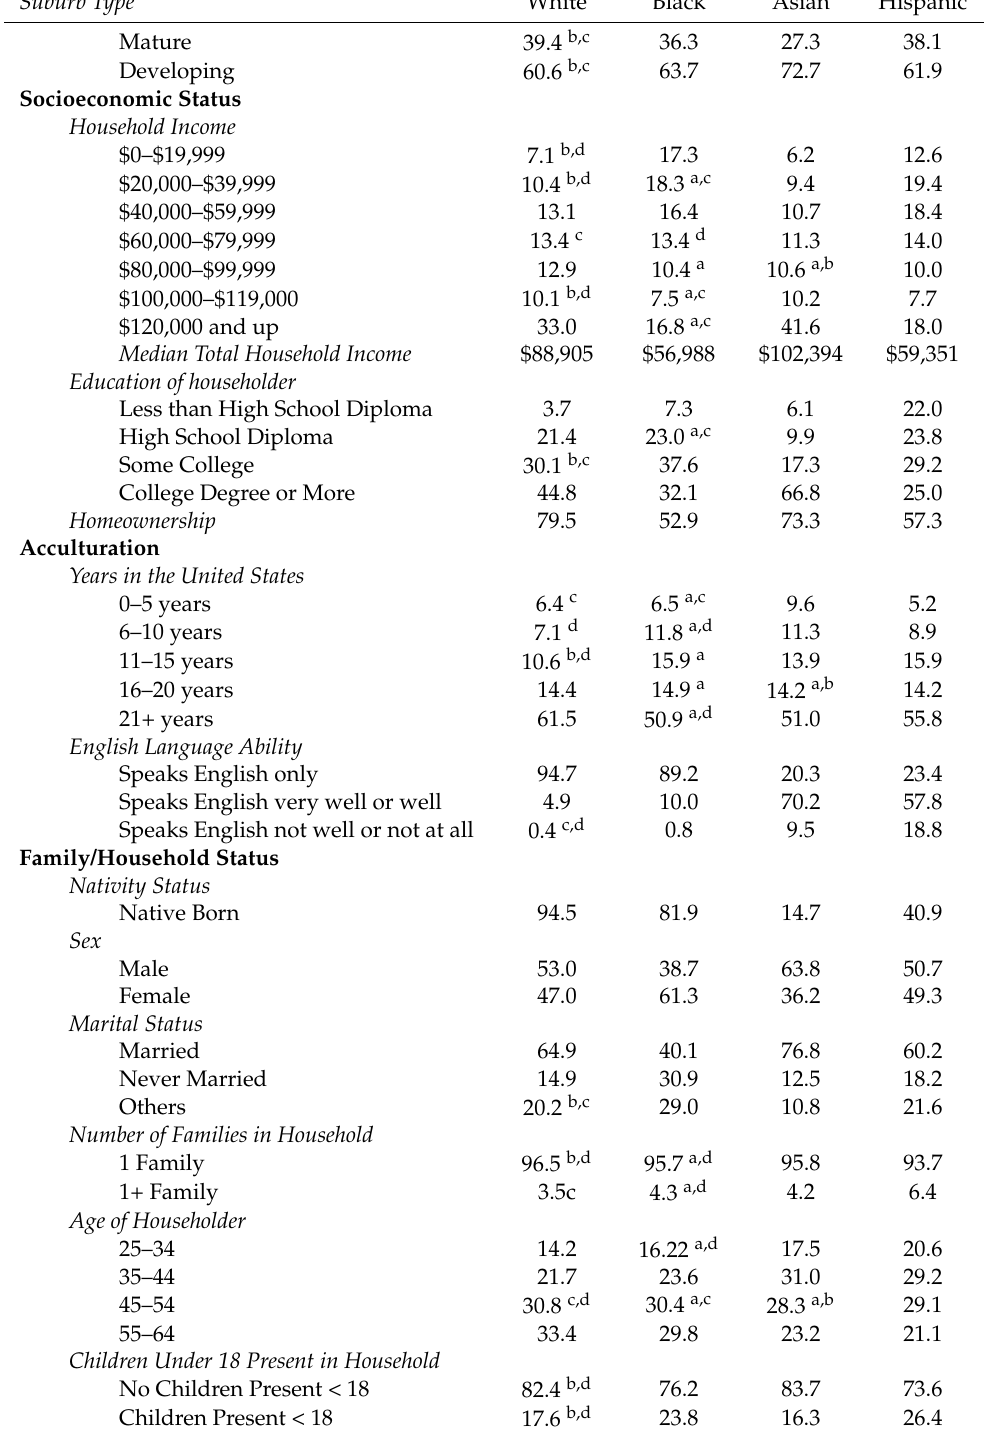
Table 1. Selected Descriptive Characteristics of White, Black, Asian, and Hispanic Households. Suburb Type